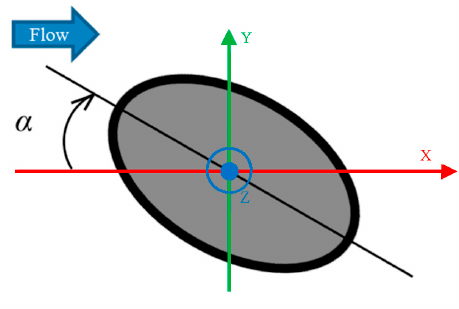
Figure 4. The definition of an angle of attack of the elliptic